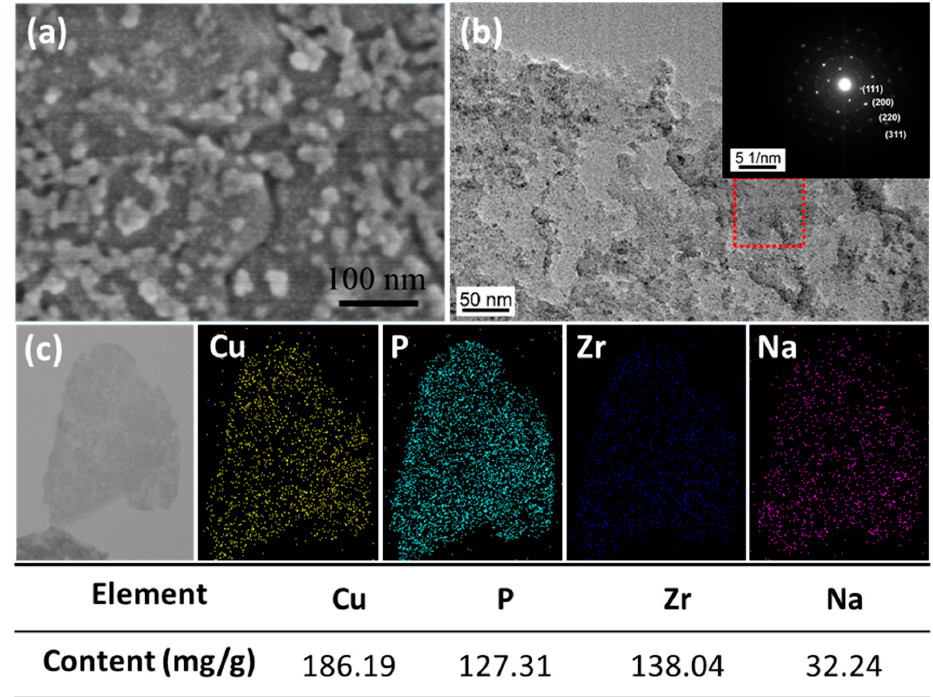
Figure 1. The structure analysis of nano-Cu 2 O@ZrP: ( a ) SEM image and ( b ) TEM image of Cu 2 O@ZrP. ( c ) Elemental mapping of the Cu 2 O@ZrP. Insert (b) shows selected area electron diffraction (SAED) patterns of the red square region. The data in the table is the element contents of Cu 2 O@ZrP.